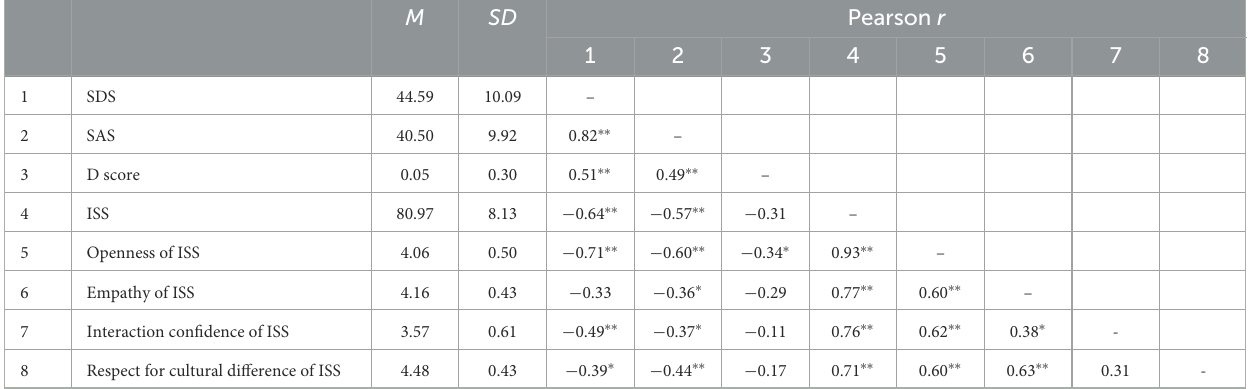
TABLE 3 Correlations among variables, means, and standard deviations ( N =